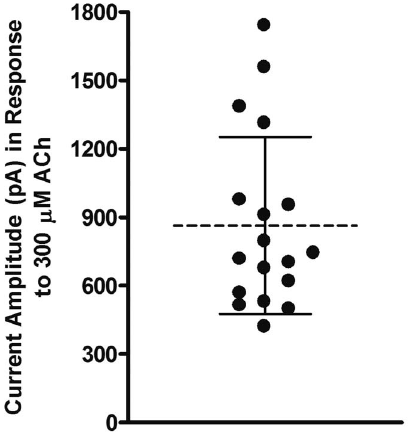
Figure 1. Acetylcholine evokes currents in monkey adrenal chromaffin cells. Scatter plot showing the current amplitudes evoked by 300 m M ACh. The dashed line denotes the mean and the error bars denote the S.D.M; n=18.